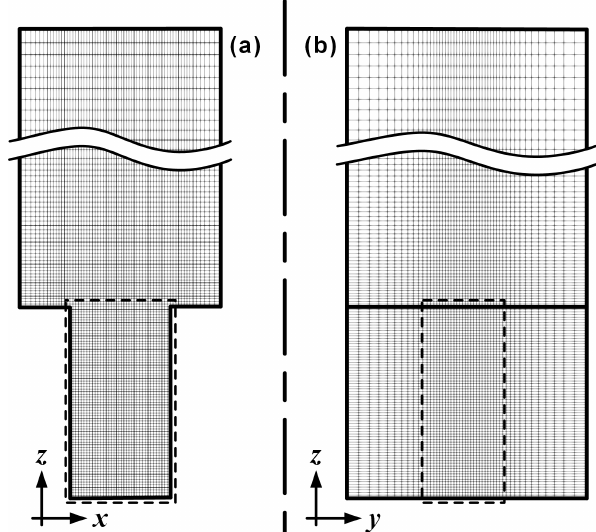
Figure 2. Grid distribution of the canyon geometry in the (a) x − z plane and (b) y − z plane. Cell size in the canyon core region (dashed line) is 0 . 5 × 0 . 5 × 0 . 5m 3